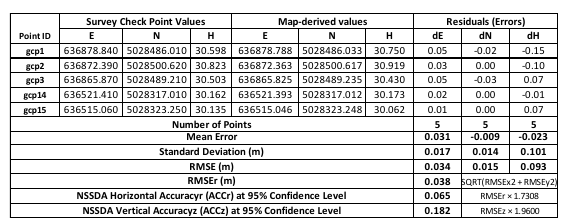
Table A4: Map Accuracy for 2 strip ISO, 30% sidelap- Fryer